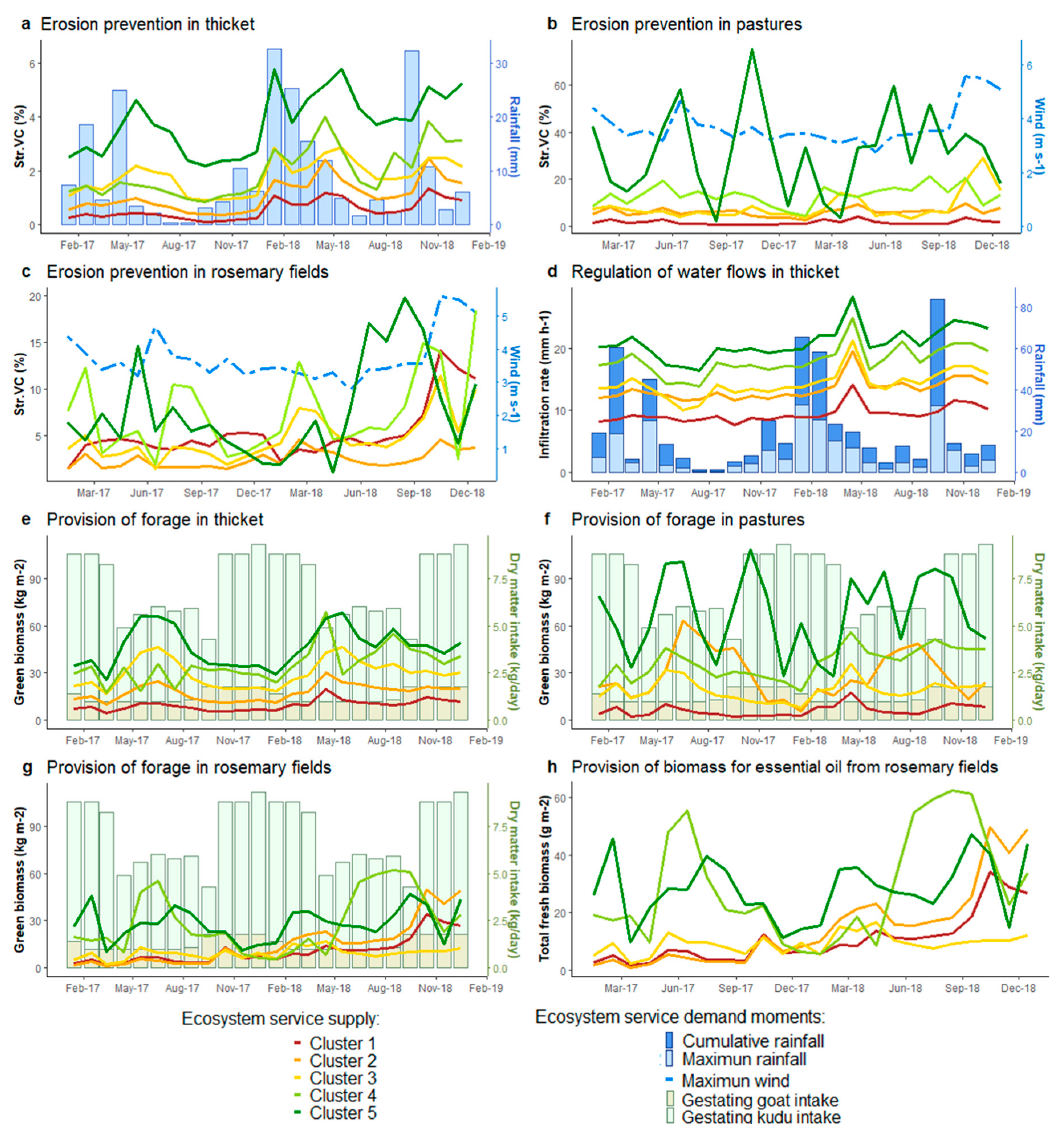
Figure 5. Temporal variation during the years 2017 and 2018 of the supply and demand of erosion prevention in five classes of erosion prevention ( a – c ), regulation of water flows ( d ), provision of forage ( e – g ), and biomass for essential oil production ( h ). Str.VC: Stratified vegetation cover.